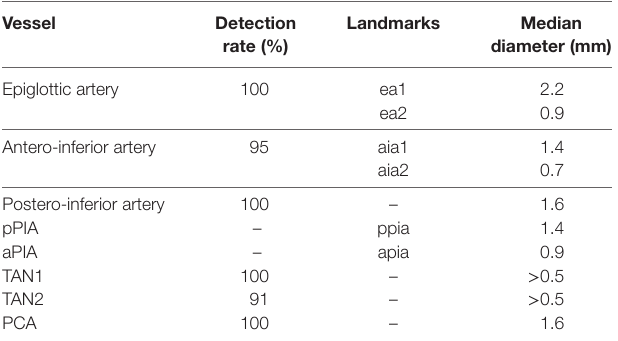
Table 1 | Summary of each vessel’s detection rate, landmarks, and median diameter.